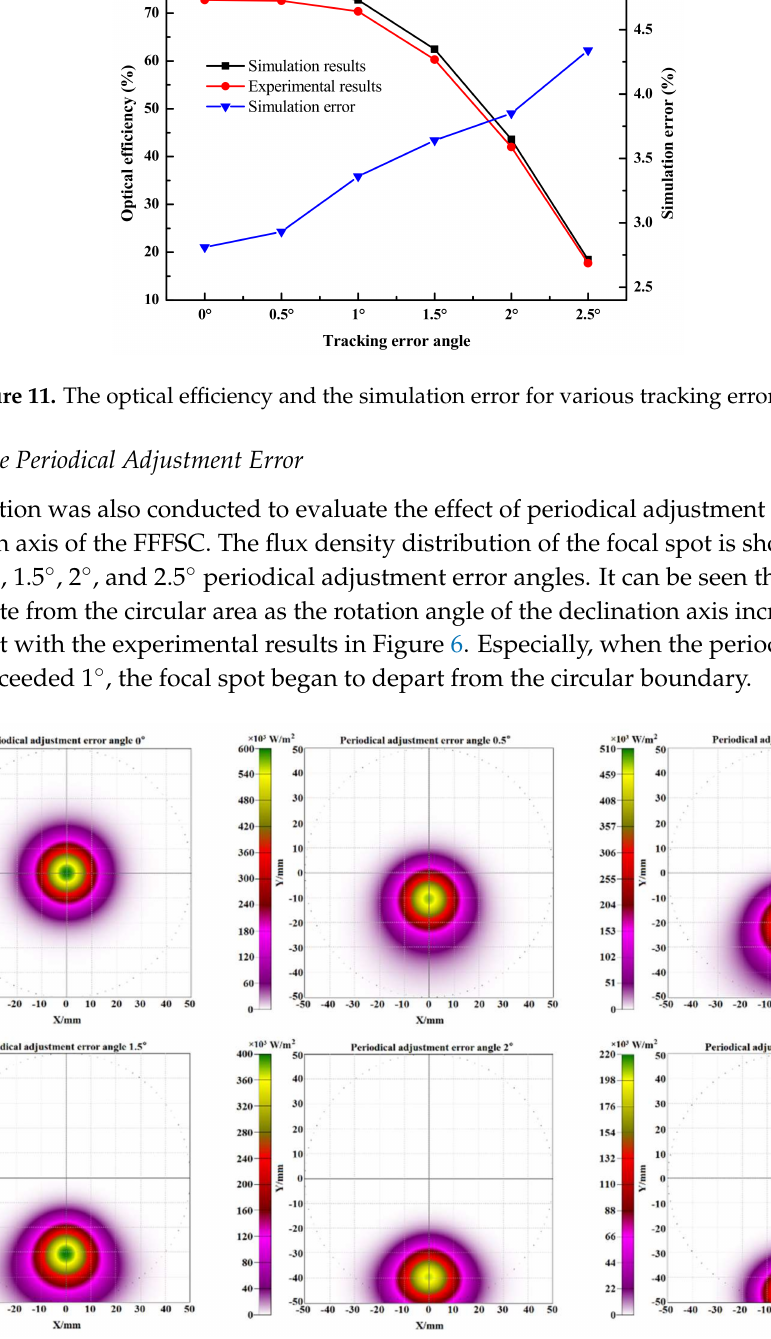
Figure 12. The density distribution of the focal spot for various periodical adjustment error